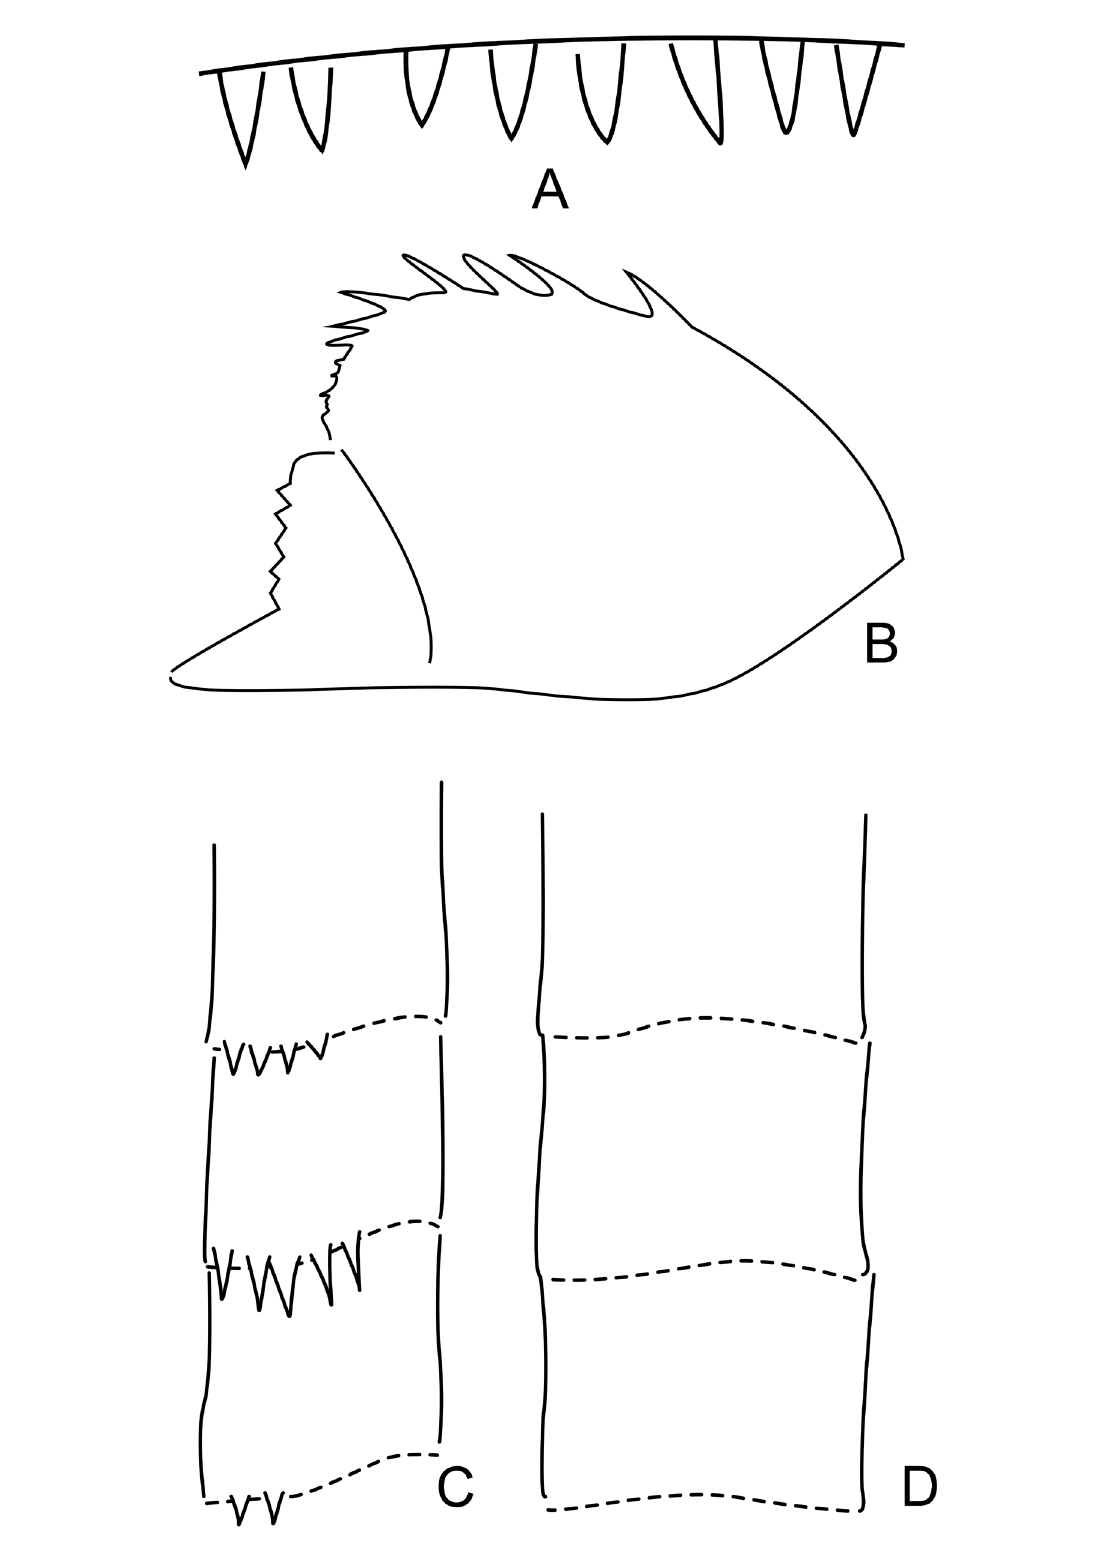
Fig. 6. Rivudiva amazona sp. nov., holotype (INPA). A . Margin of tergum IV. B . Paraproct. C . Cercus. D . Paracercus. Not to